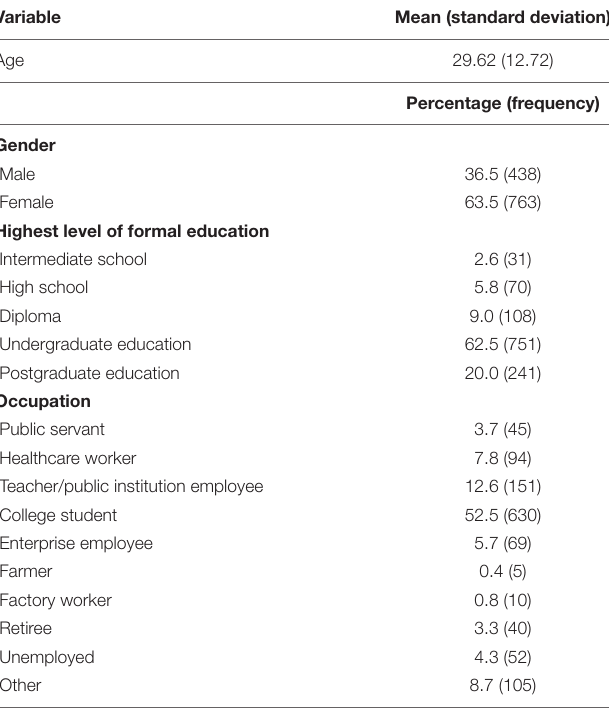
TABLE 1 | Participant demographic